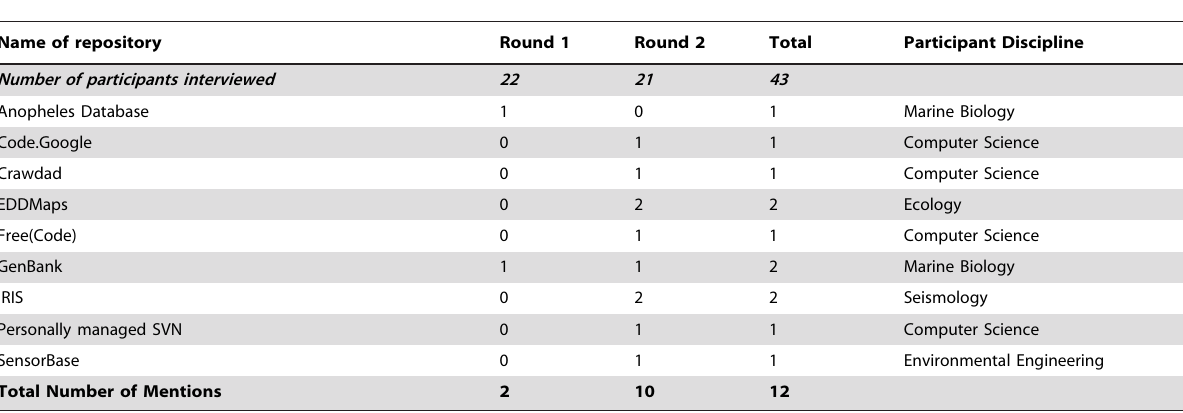
Table 4. Repositories used by participants to share